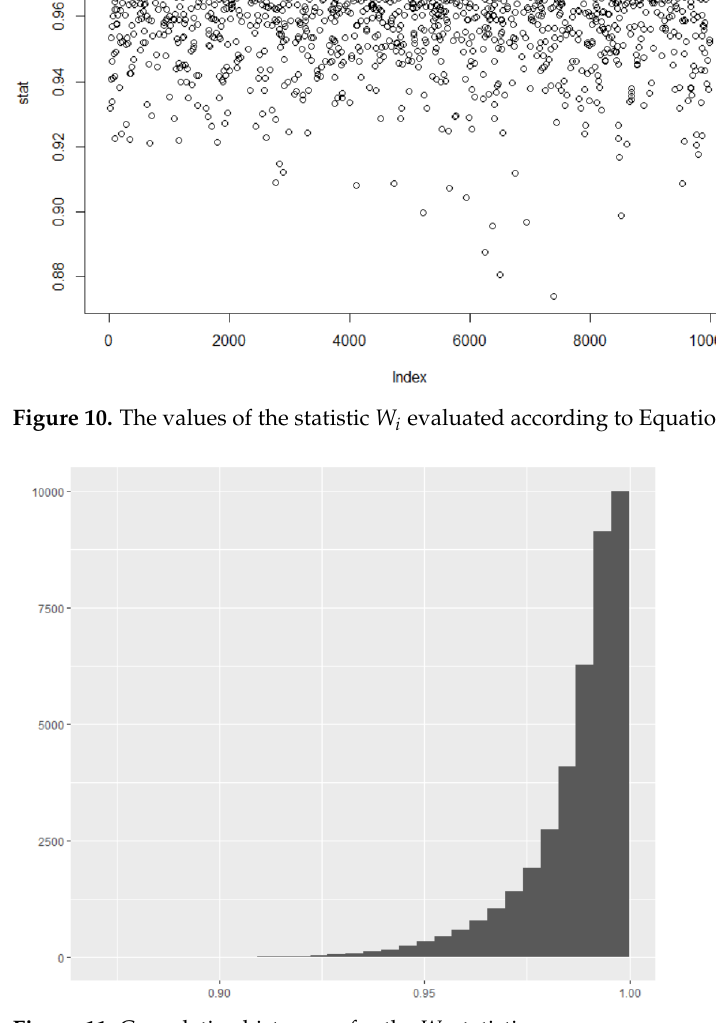
Figure 11. Cumulative histogram for the W i